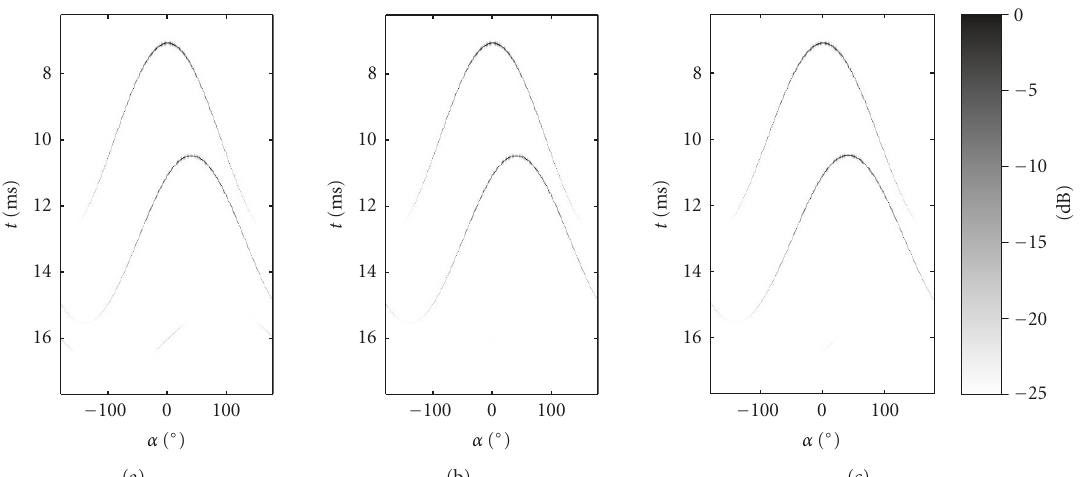
Figure 11: Results of subtracting the reconstructed response of the wave with elevation angle θ = 70 ◦ from the data set of Figure 3, after selecting the data in the model space using filter windows “a,” “b,” and “c” (indicated in Figure 10), respectively.